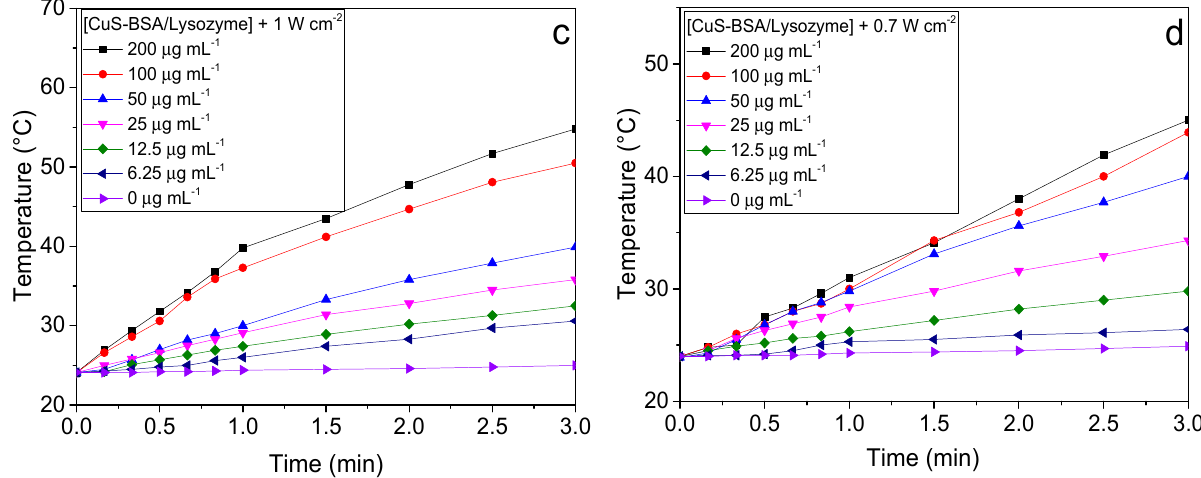
Figure 4. Photothermal heating curves of ( a , b ) CuS-BSA and ( c , d ) CuS-BSA/lysozyme at various concentrations in 0.01 mol L − 1 PBS under NIR illumination (980 nm) under a continuous wave laser irradiation at different power densities for 3 min.